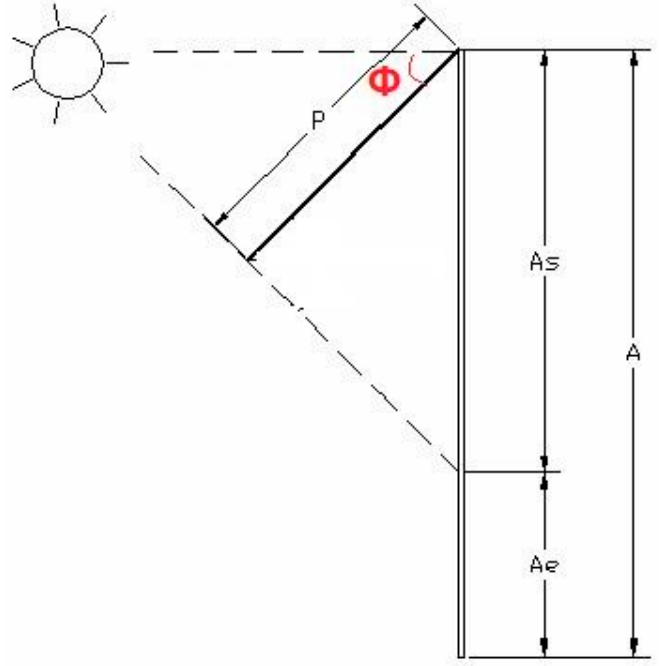
Figure 17. SC2 calculation by using the proposed method.